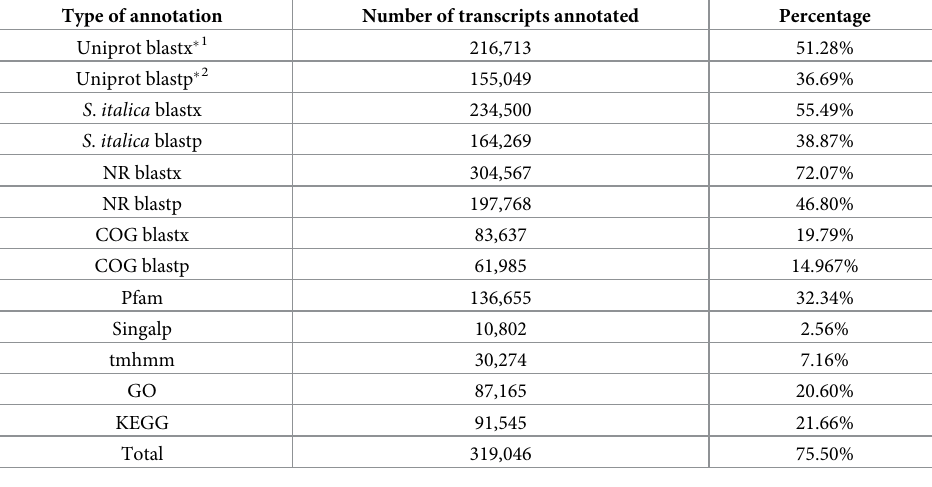
Table 3. Summary for annotation results of transcriptome assembly